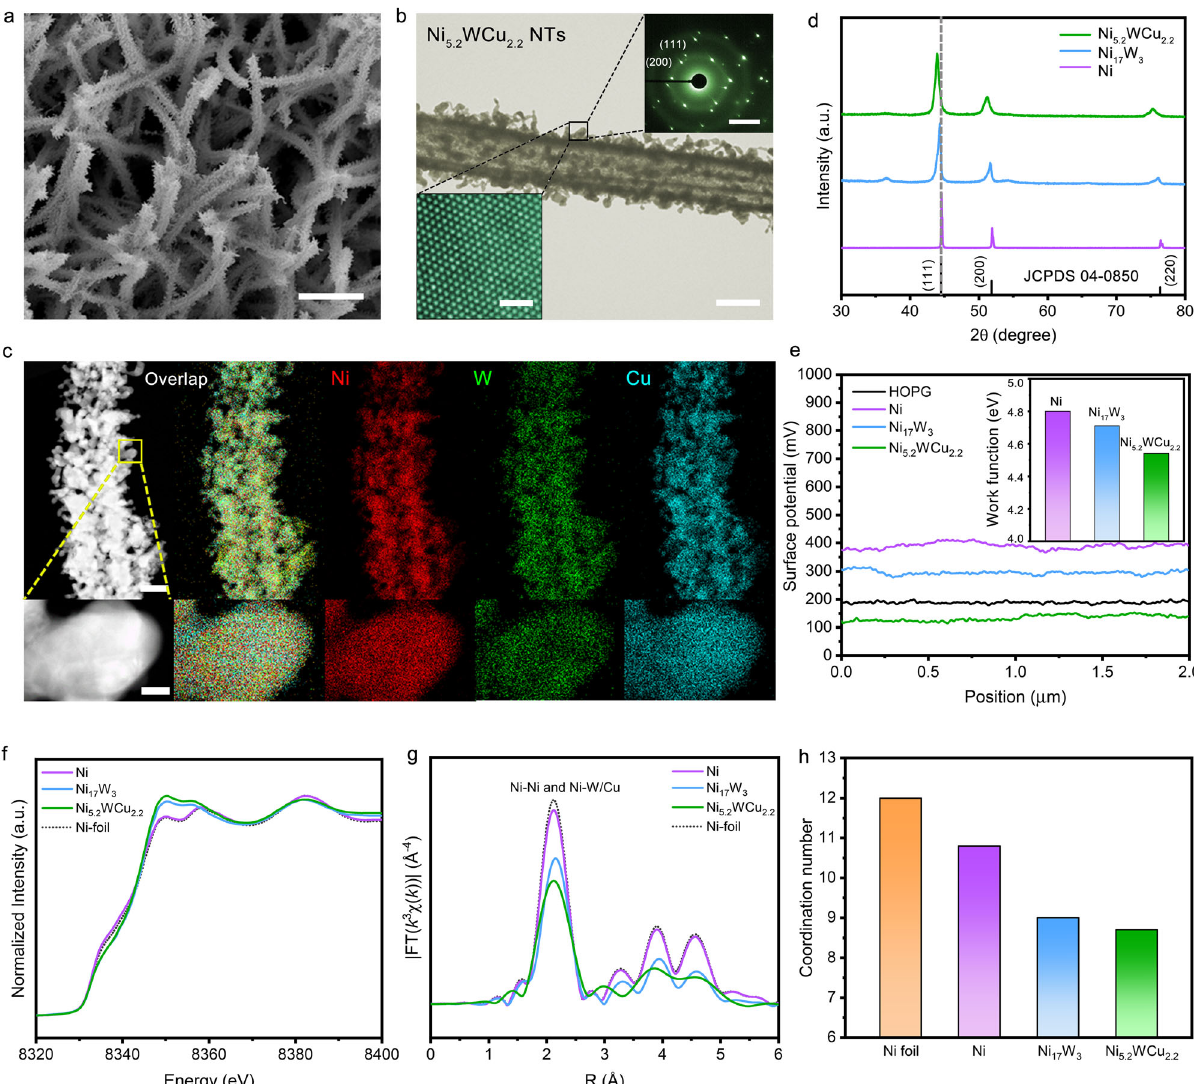
Fig. 2 Characterization and structural analysis. a SEM image of Ni 5.2 WCu 2.2 alloy. Scale bar, 2 μ m. b TEM image of Ni 5.2 WCu 2.2 alloy. Scale bar, 250 nm. Insets show SAED pattern (up; scale bar, 5 1/nm) and the atomic-resolution HAADF-STEM image (down; scale bar, 1 nm), respectively. c STEM-EDX elemental mappings of Ni 5.2 WCu 2.2 alloy, showing a uniform spatial distribution of Ni, W, and Cu. Scale bars, 200 nm (up) and 20 nm (down). d XRD patterns of Ni, Ni 17 W 3 and Ni 5.2 WCu 2.2 , respectively. e Surface potential pro fi les along the white lines in Supplementary Figure 10 for Ni, Ni 17 W 3 , Ni 5.2 WCu 2.2 and HOPG reference, respectively. Inset shows the resultant work function values for the studied catalysts. f , g Ni K-edge XANES spectra and corresponding Fourier transforms of k 3 -weighted EXAFS spectra for Ni, Ni 17 W 3 , Ni 5.2 WCu 2.2 and Ni foil reference. h The average coordination number in the fi rst coordination shell of Ni atoms for Ni, Ni 17 W 3 , and Ni 5.2 WCu 2.2 by EXAFS spectra curve fi tting. The coordination number of Ni foil reference is